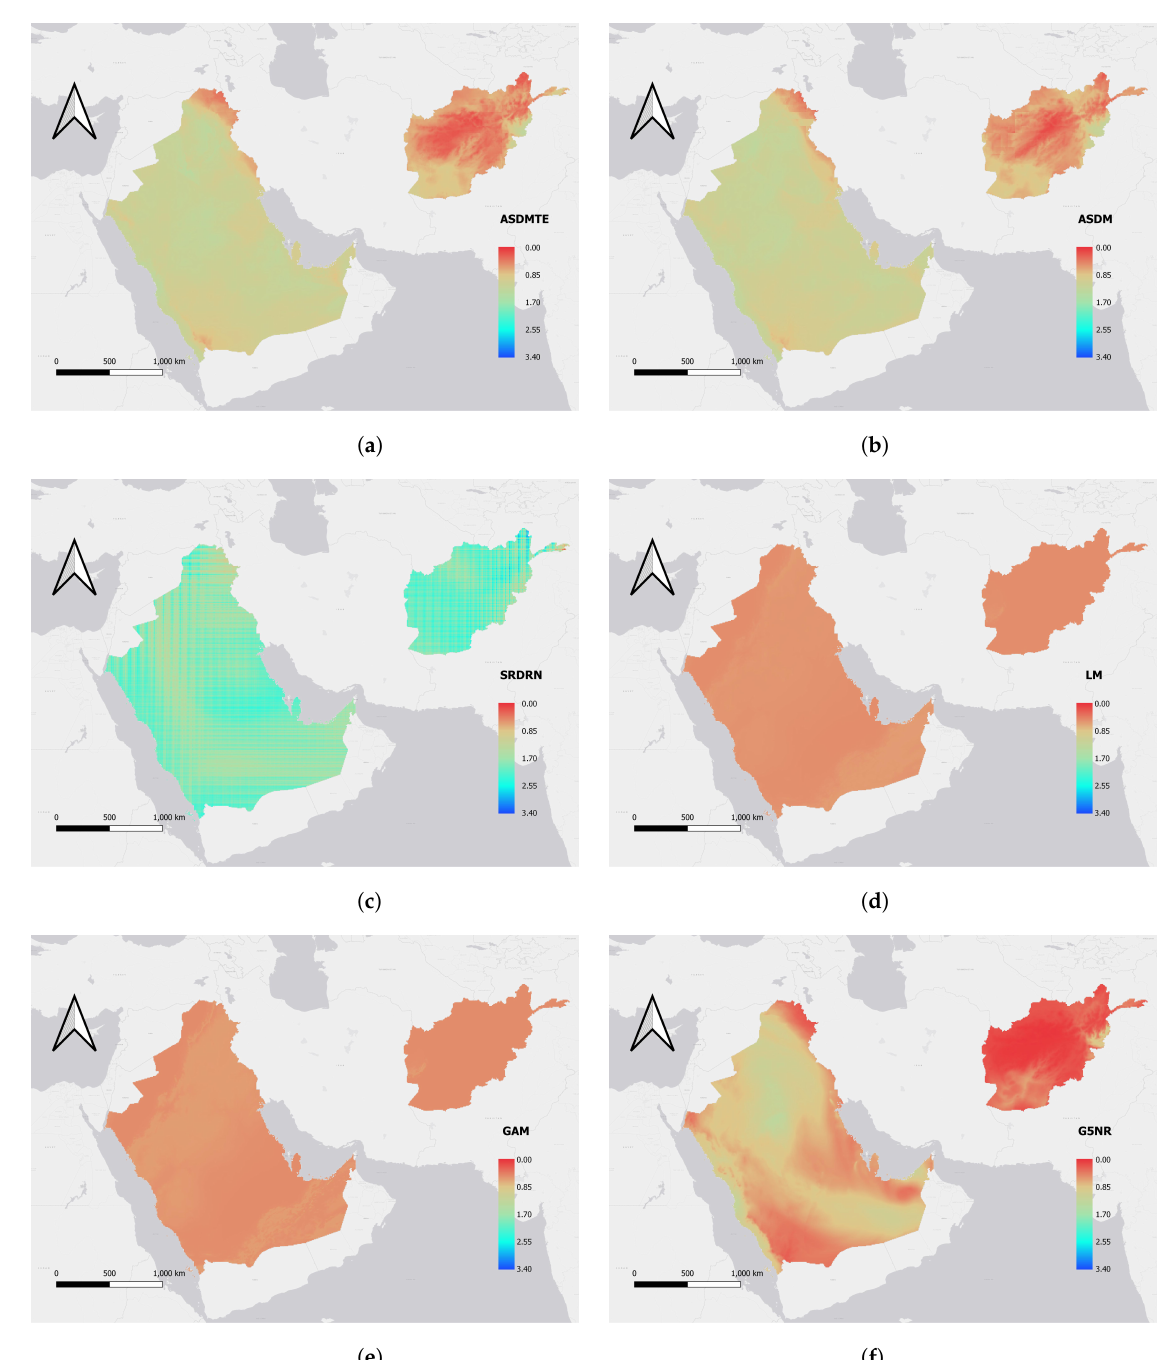
Figure A5. Downscaled (by method) and G5NR data over the study region on 23 October